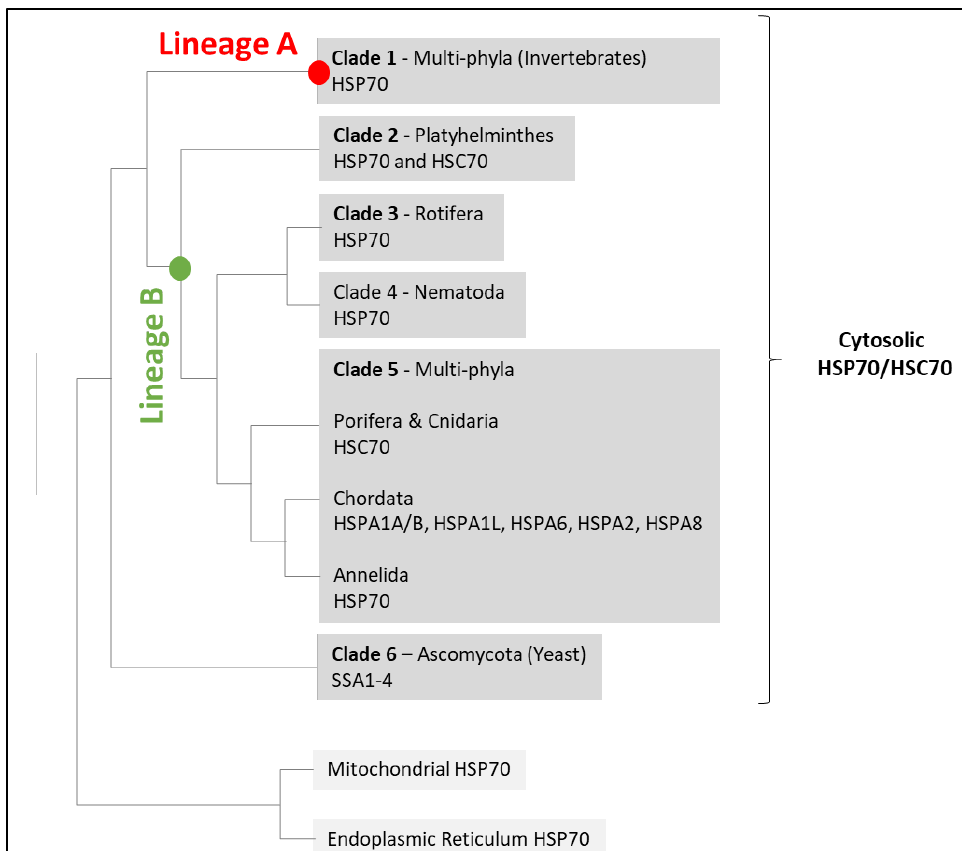
Figure 3. Proposed tree topology of HSP70/HSC70 family members in metazoans (adapted from Yu et al. [32]). Red and green circles show the nodes that give birth to Lineage A of invertebrate HSP70s (clade 1) and Lineage B of both vertebrate and invertebrate HSP70s and all HSC70 genes, respectively. This second lineage has further diversified within diverse phyla: Platyhelminthes (clade 2), Rotifera (clade 3), Nematoda (clade 4), and Chordata (clade 5). Clades 1 to 6 include only cytosolic members of the HSP70 family.